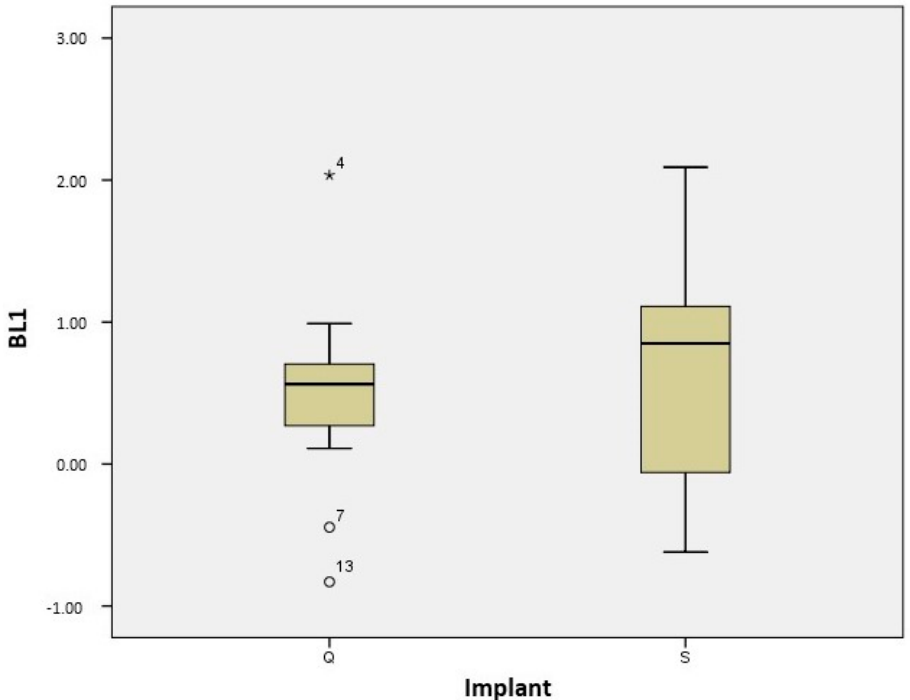
Figure 4. Box plot of the bone level for both implant designs at loading (baseline), with no statistically significant difference between them. S = Standard implant, Q = Quattro implant. O = Outliers. * = Extreme outliers